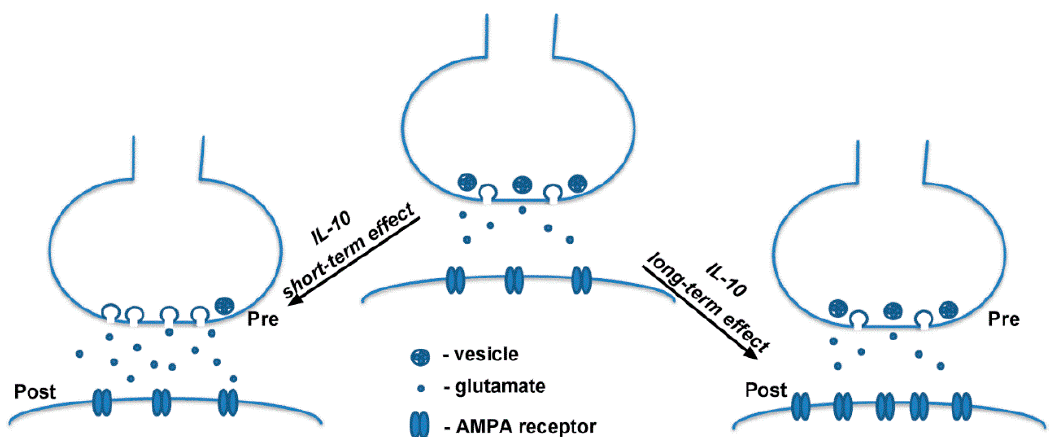
Figure 5. Working model of IL-10 action on synaptic activity. Short-term effect of IL-10 on synaptic activity might be associated with its action on probability of vesicle release at presynaptic site. Long-term effect of IL-10 might be related to its action on the AMPA receptor expression level at postsynaptic site.